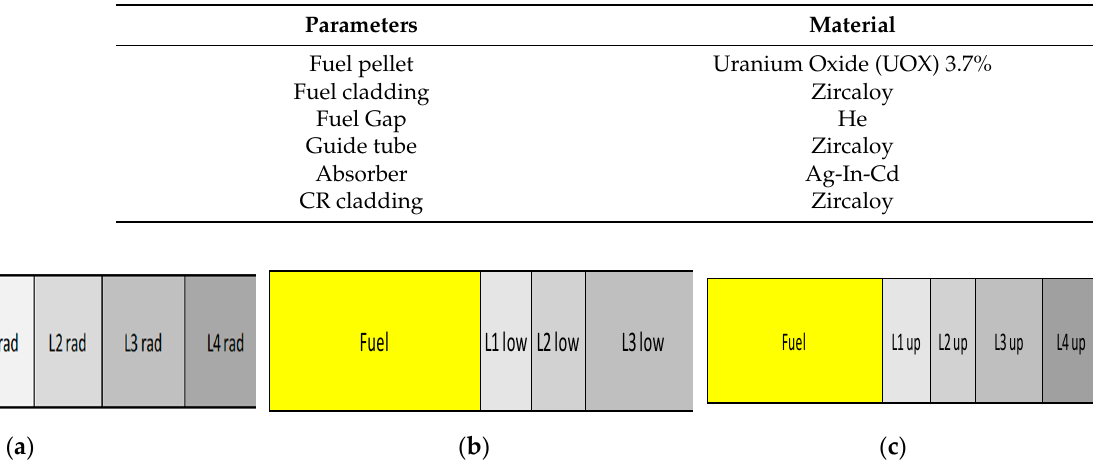
Figure 3. 32 FA PWR minicore layout. Reflector models: ( a ) radial reflector; ( b ) axial lower reflector; ( c ) axial upper reflector. Table 1. 32 FA PWR minicore layout and conditions. Table 4. 32 FA PWR minicore: simplified reflectors models description (see Figure 3). SS304: Stainless Steel